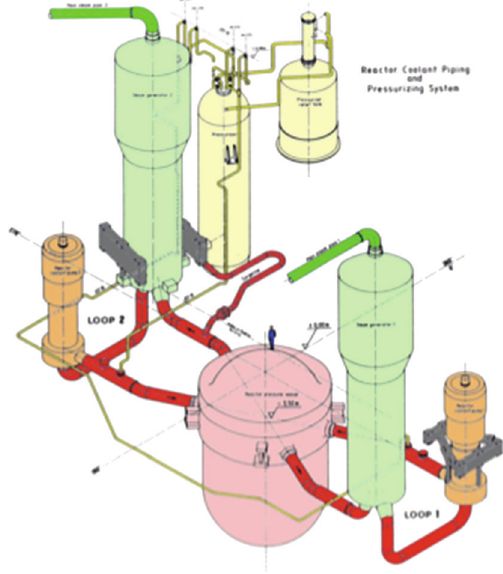
Figure 1: Atucha-2 NPP layout.